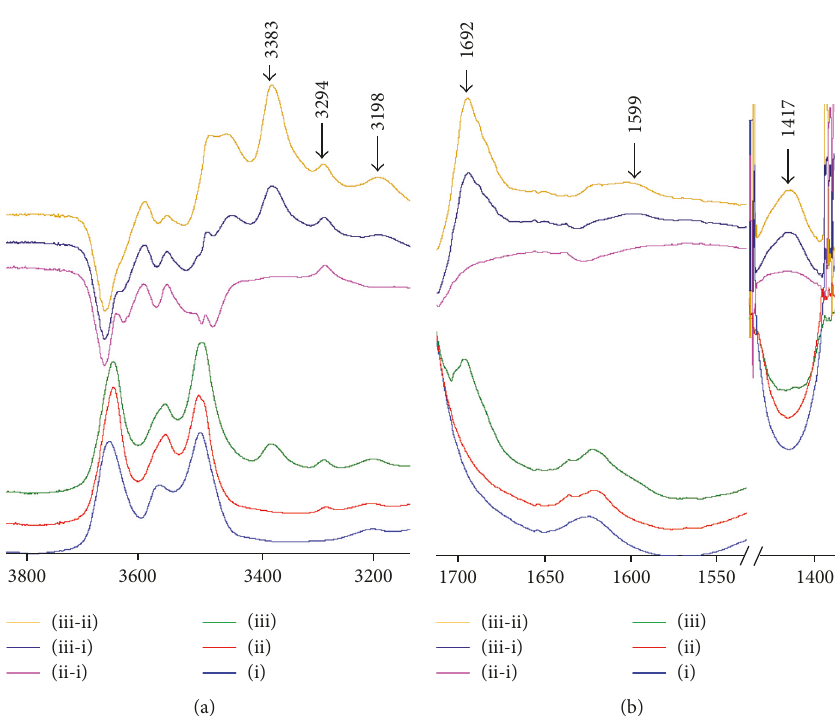
Figure 3: FTIR (transmission) spectra of neat (i), blank (ii) and grafted PLA (iii) films. Subtracted (difference) FTIR spectra of the corresponding samples are shown on the upper part.